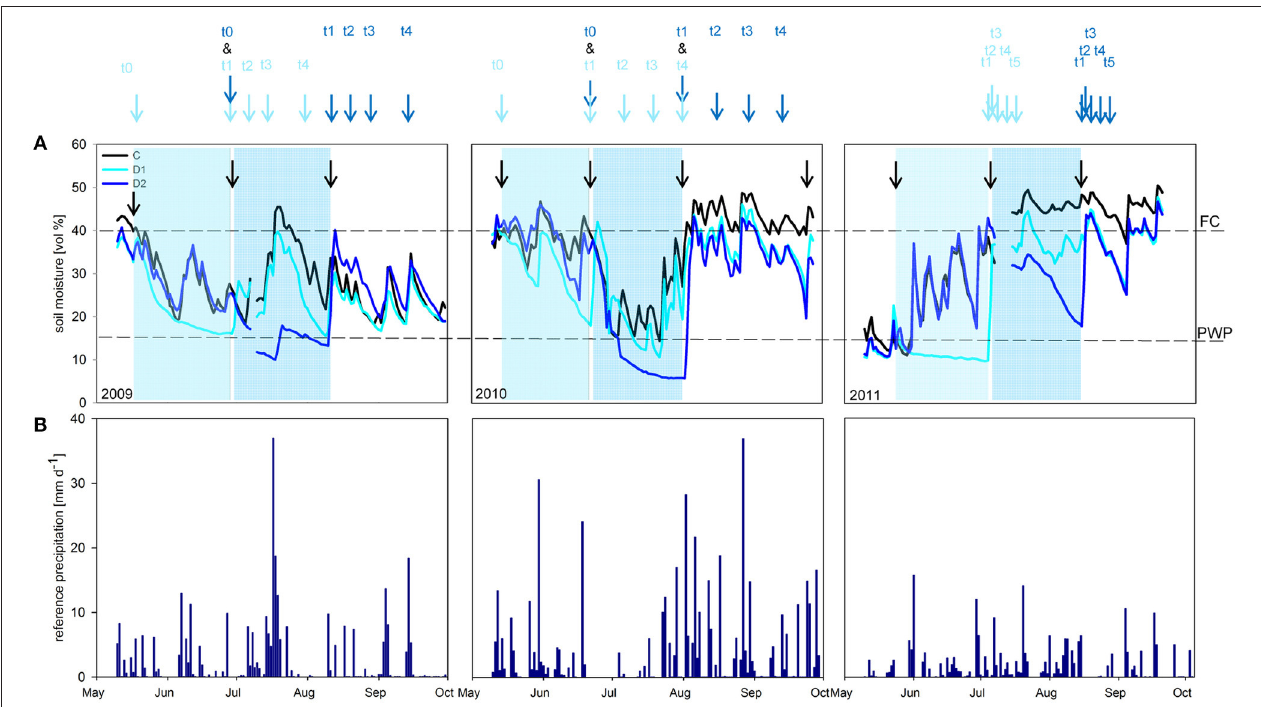
FIGURE 1 | (A) Volumetric soil moisture [vol %] for the sampling years 2009 - 2011. Results for control (C; black line), spring drought (D1; light blue line) and summer drought (D2; dark blue line). Compensation irrigations during the experimental time are marked with black arrows. Light blue rectangles indicate the D1 treatments (May - June) and dark blue rectangles the D2 treatments (July - August). Dotted lines show field capacity (40 vol %; FC) and permanent wilting point (15 vol %; PWP). Sampling time points are indicated with arrows. (B) Reference precipitation [mm d-1] for the sampling years